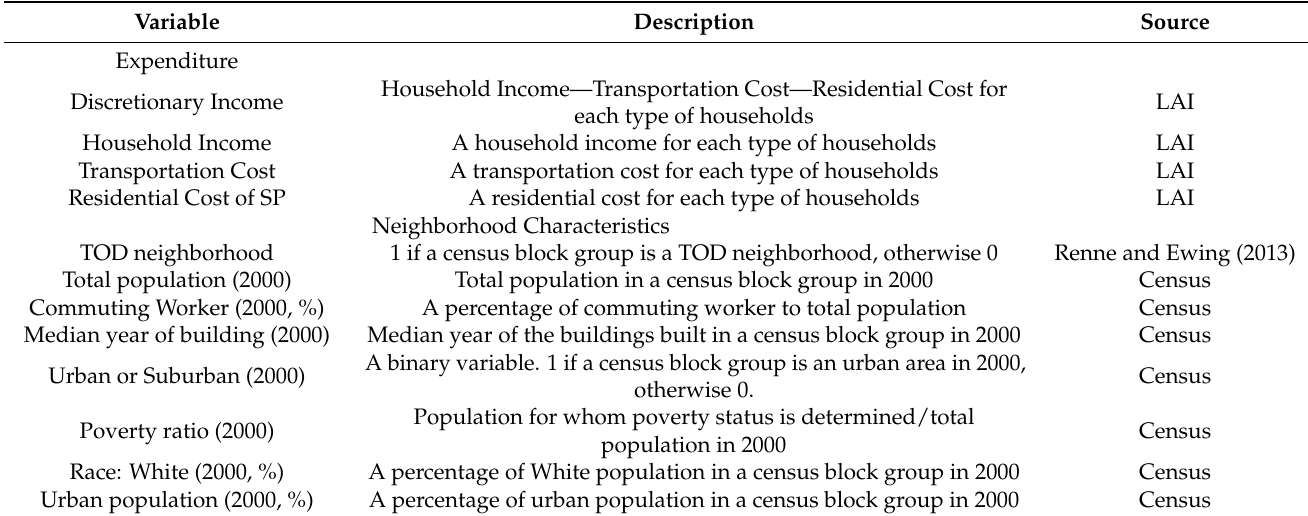
Table 2. List of